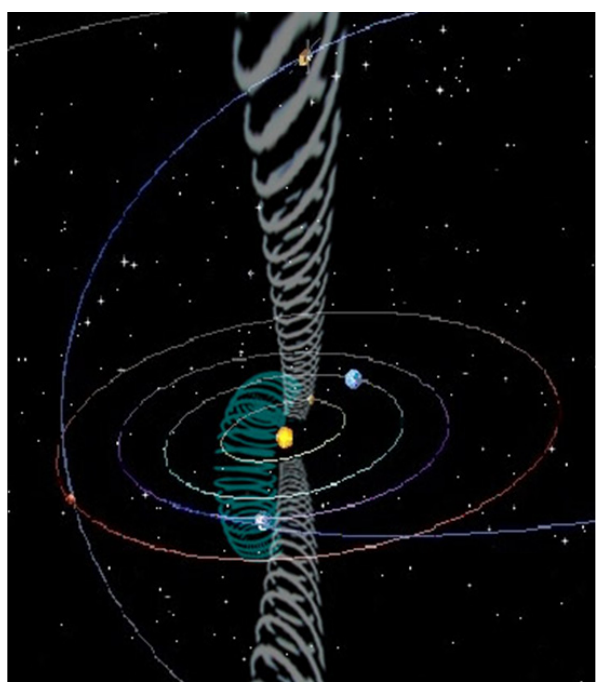
Fig. 8. A sketch showing the scenario of the 3-D magnetic cloud topology as it travels far away from the Sun (blue colour corre- sponds to the cloud when it passes the ACE spacecraft, and grey colour corresponds to the cloud when it is observed by Ulysses).